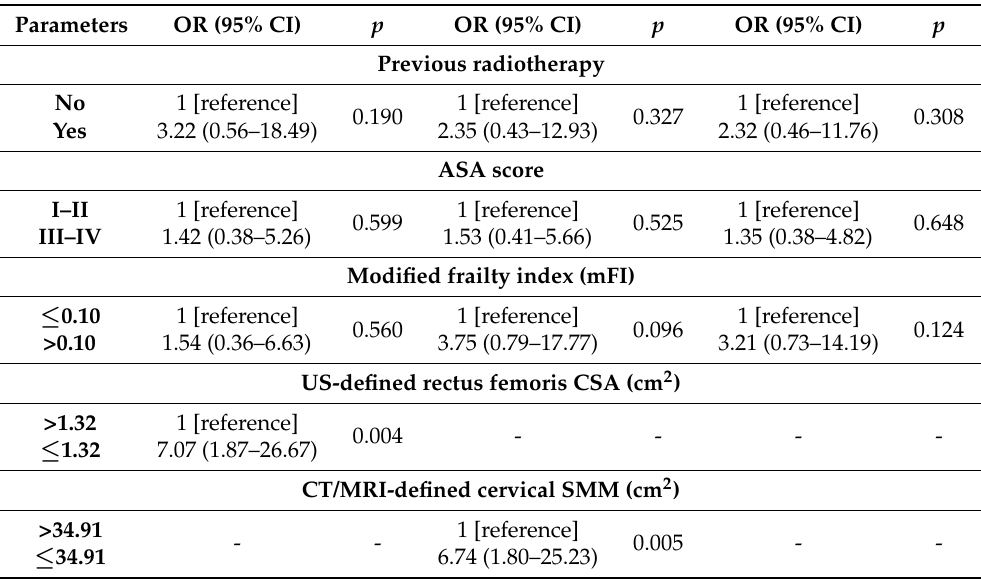
Table 3. Thirty-day major postoperative complications and dichotomized clinical predictors, mul- tivariate analysis (multiple logistic regression); ASA: American Society of Anesthesiologists; CSA: cross-sectional area; SMM: skeletal muscle mass; CSMI: cervical skeletal muscle index.